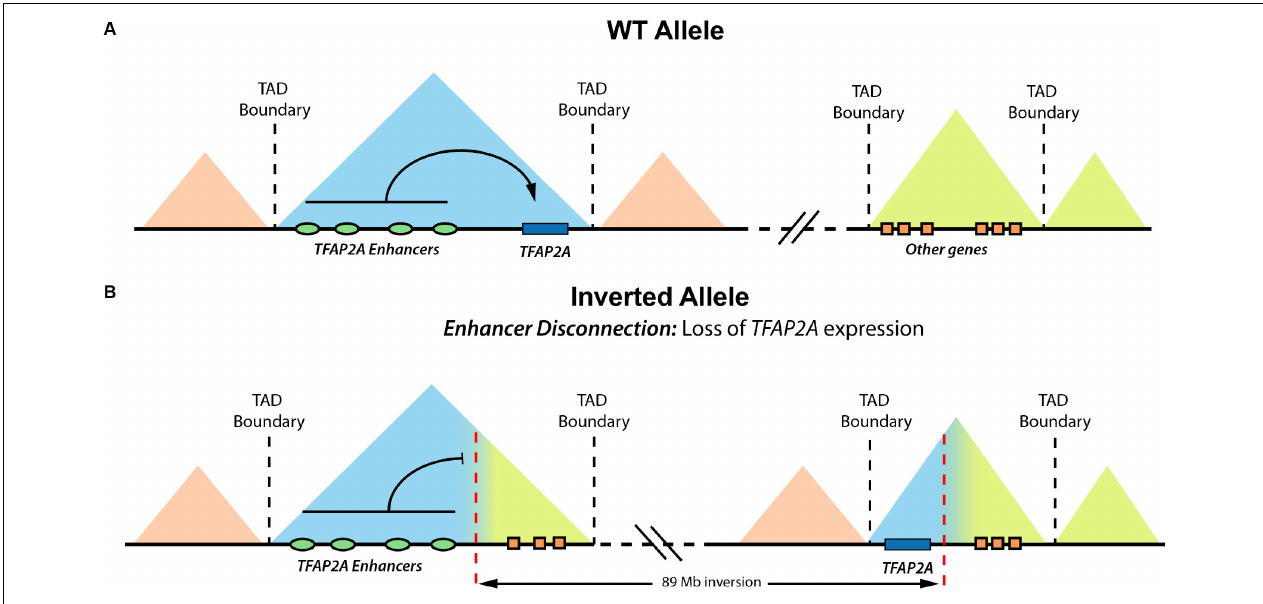
FIGURE 2 | Enhancer disconnection in a reported BOFS patient. Graphical overview of how an heterozygous inversion found in a BOFS patient causes the physical disconnection between TFAP2A and its enhancers, leading to haploinsufficient TFAP2A expression in human neural crest cells (hNCCs). (A) Schematic representation of the wild-type (WT) TFAP2A allele. (B) Schematic representation of the altered TFAP2A allele, where an inversion disconnects TFAP2A from its cognate enhancers. Modified from Laugsch et al.